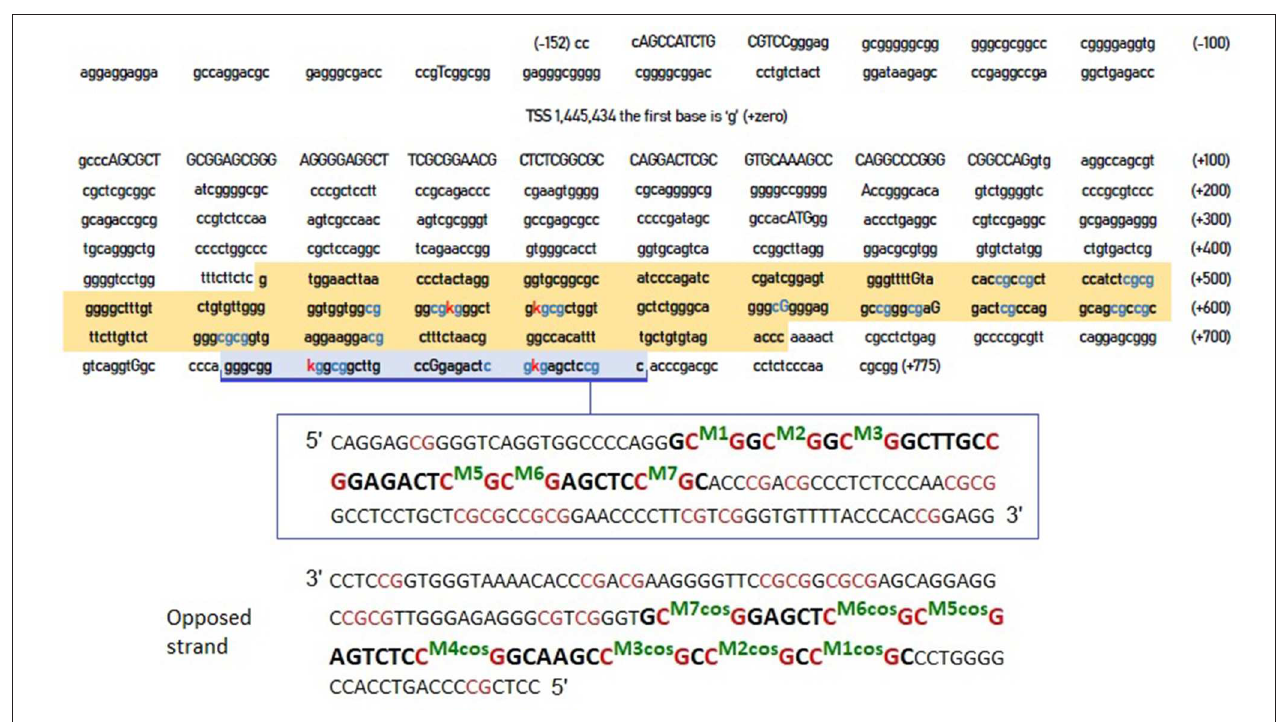
FIGURE 1 | DNA sequence of DAT gene 5’-UTR. The sequence highlighted in orange is that examined by Xu et al. (2015). The area highlighted in blue is the one examined in our previous study ( Adriani et al., 2018). The blue CpG islands are those that are likely to be methylated, whereas the red “K” are the specific cytosines that the two studies report to be hyper methylated in ADHD. The inset (below) provides a further detail of the blue-highlighted area, together with its complementary sequence on the opposite strand (reported as forward strand, from its 5’ to its 3’) and CpG numerations. COS, complementary on the opposite